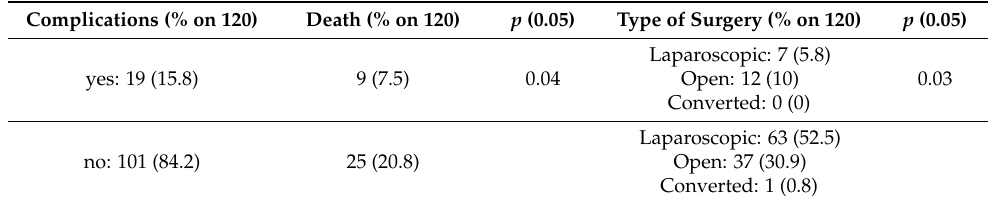
Table 4. Complications and their %, mortality and its %, type of surgery and its %, and p (0.05).